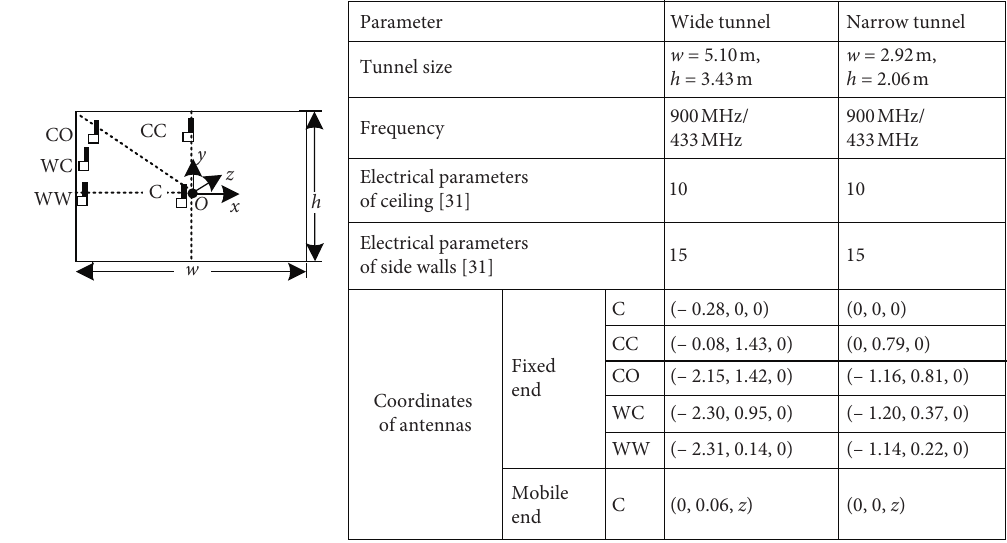
Figure 4: Simulation parameters of the equivalently surrogated tunnel. Table 6: Maximum boundary for horizontal polarization modes and vertical polarization modes at 900MHz frequency in the wide tunnel (in